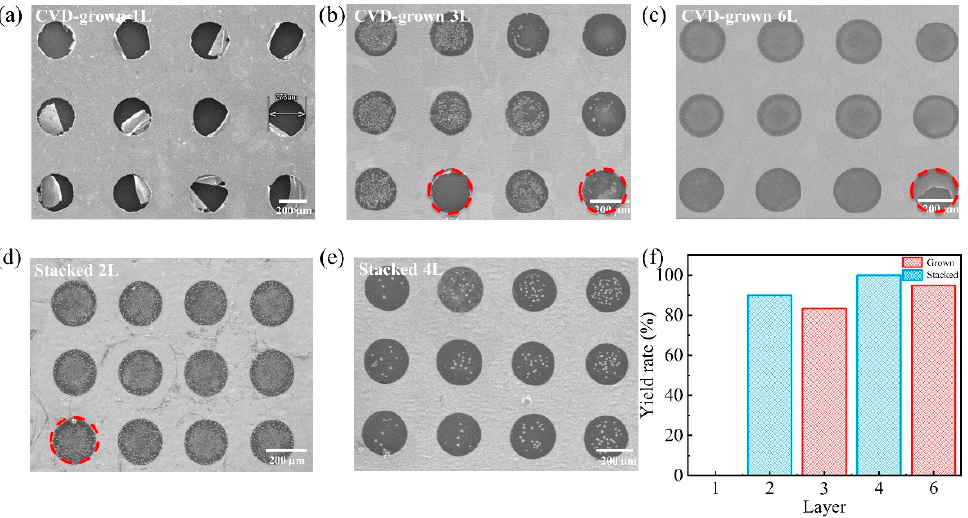
Figure 3. SEM images of ( a ) CVD-grown 1L graphene, ( b ) CVD-grown 3L graphene, ( c ) CVD-grown 6L graphene, ( d ) stacked 2L graphene film, ( e ) stacked 4L graphene film suspended on the circular holes in diameter of 200 µ m. ( f ) Summary of the survival rate of suspended graphene film on the circular holes with a diameter of 200 µm with di ff erent layers and using di ff erent methods.